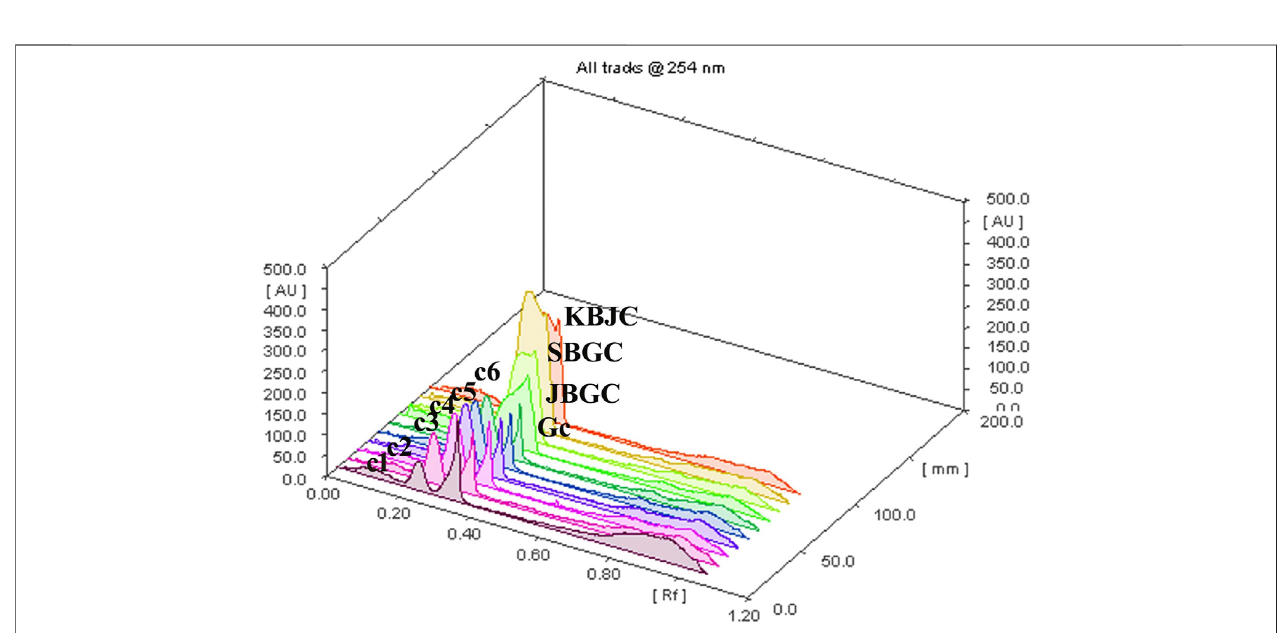
FIGURE 8 | TLC plate scanned at 254 nm showing berberine chloride hydrate in the 3D samples chromatogram.